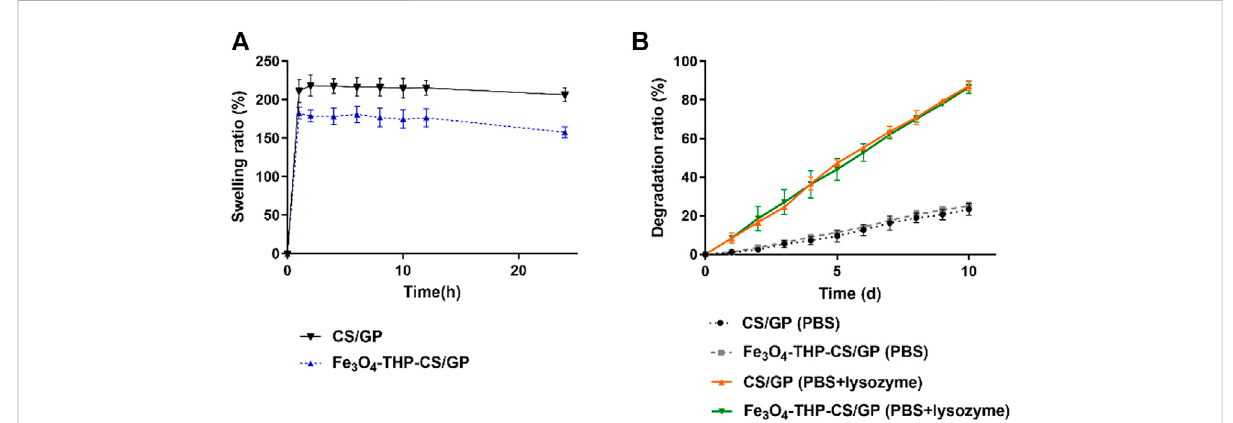
FIGURE 3 Linechartof swelling andthedegradationrateof differentgels. (A) CS/GP andFe 3 O 4 -THP-CS/GPgel had goodswelling properties, and the swelling equilibrium was reached in about 1 h (211.50% ± 15.00% vs. 182.50% ± 8.10%; p < 0.05), but the swelling property of Fe 3 O 4 -THP-CS/GP was signi fi cantly lower than that of CS/GP. (B) Degradation of CS/GP and Fe 3 O 4 -THP-CS/GP gels in pure PBS was slow, and the degradation rate was less than 30% in 10 days. After lysozyme was added, the degradation rate of the two was signi fi cantly accelerated. The degradation rate of different solvents was signi fi cantly different on the 10th day (23.30% ± 3.08% vs. 87.17% ± 2.55%, p < 0.0001 for CS/GP; 25.13% ± 1.94% vs. 86.65% ± 3.21%, p < 0.0001 for Fe 3 O 4 -THP-CS/GP).